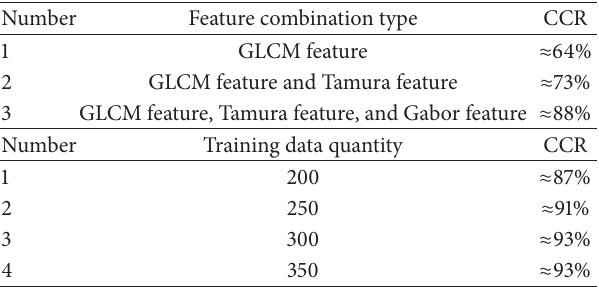
Table 5: The CCR analysis results using different training condi- tions.